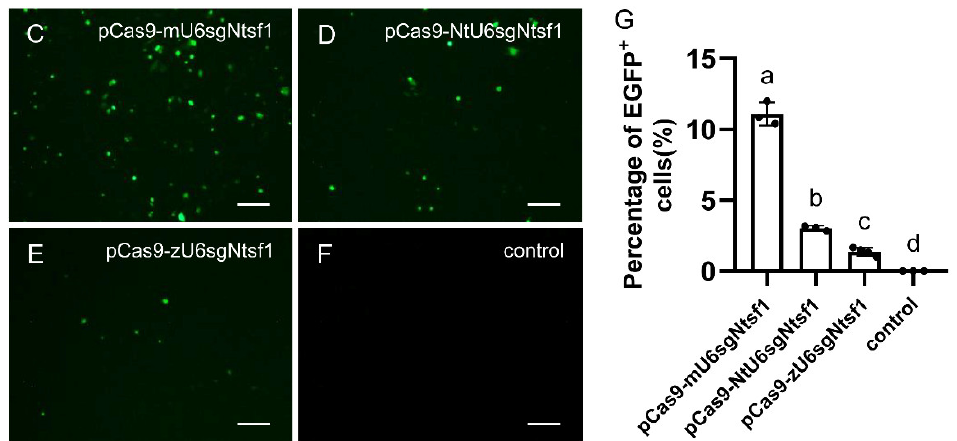
Figure 1. The effect of U6 promoters derived from different species on gene editing efficacy in medaka cultured cells. The integrated pCas9-U6sgRNA plasmids containing U6 promoter derived from different species was constructed. Then it was transfected into medaka cultured cells SG3 together with pGNtsf1 reporter vector. The gene editing efficacy was evaluated by observing EGFP signals 48 h after transfection. ( A ) Diagram of pCas9-U6sgRNA plasmid. ( B ) Diagram of construction strategy of the reporter plasmid pGNtsf1. pCVpf was used as backbone. ( C – F ) SG3 cells were co-transfected with pCas9-U6sgRNA and pGNtsf1. The sgRNA targeting Nile tilapia sf1 in pCas9-U6sgRNA is driven by U6 promoters derived from medaka (pCas9-mU6sgNtsf1) ( C ), Nile tilapia (pCas9-NtU6sgNtsf1) ( D ) and zebrafish (pCas9-zU6sgNtsf1) ( E ), respectively. SG3 cells transfected only with pGNtsf1 were set as negative control ( F ). Scale bars, 100 μm. ( G ) Quantification of the percentage of EGFP + cells in different groups. Data are shown as means ± standard derivation. Different letters above the error bar indicate statistical differences ( p < 0.05). U6, U6 promoter; sgRNA, spacer of sgRNA; scaffold, guide RNA scaffold for the Streptococcus pyogenes Cas9; CMV, the promoter of mouse cytomegalovirus; Cas9, zebrafish codon-optimized version of Streptococcus pyogenes Cas9; SV40, the simian virus 40 enhancer and early promoter; NeoR, neomycin resistance gene; PuroR, puromycin resistance gene; EGFP, enhanced green fluorescent protein; Ntsf1, sgRNA target sequence of Nile tilapia sf1